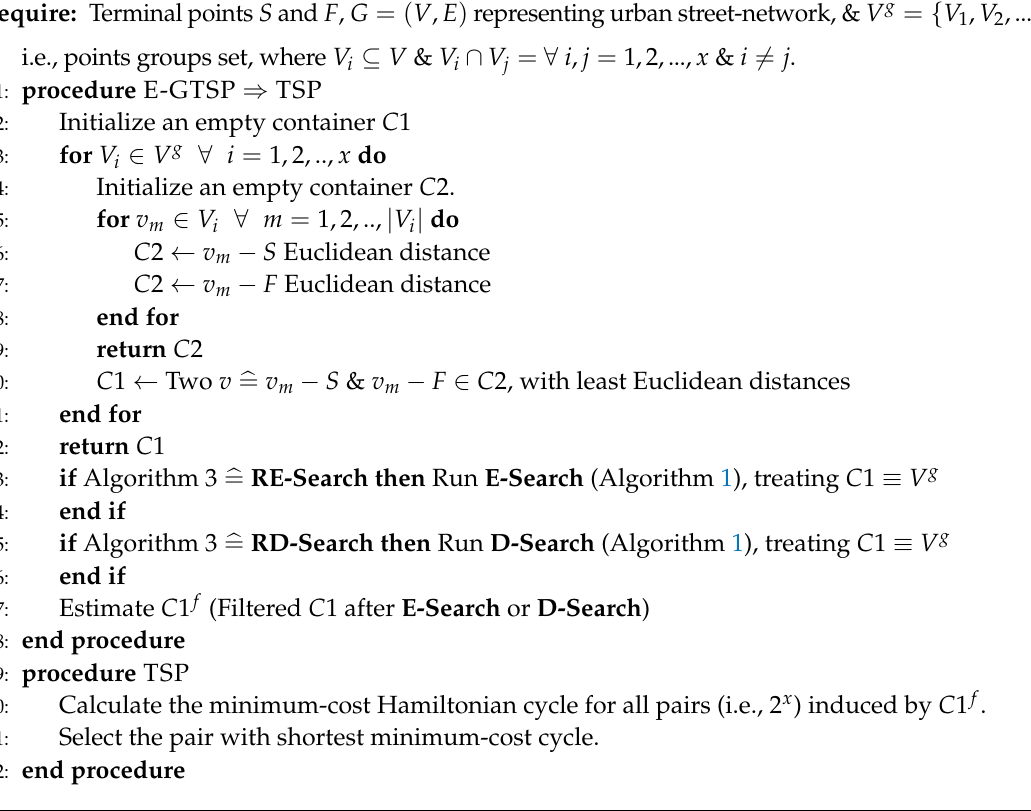
Algorithm 3 RE-Search and RD-Search